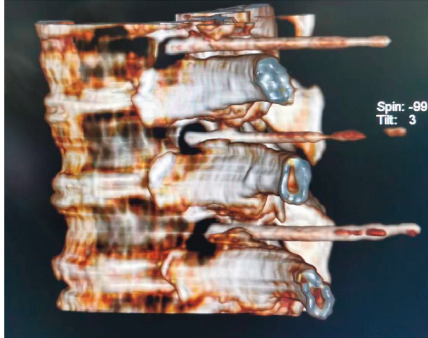
Figure 2: Three-position reconstruction of corresponding